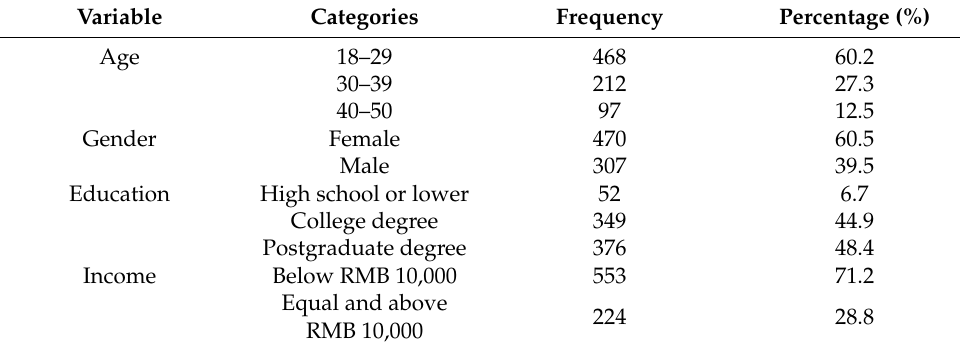
Table 1. Demographic profile of